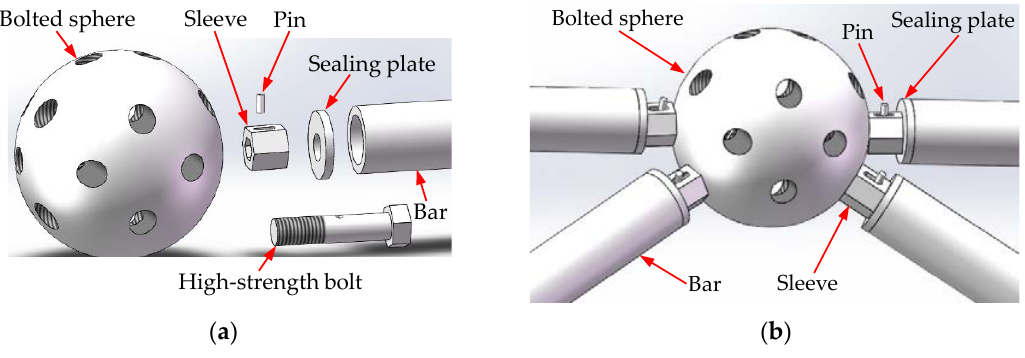
Figure 1. Diagram of bolt-sphere joint structure: ( a ) Bolt-sphere joint parts; ( b ) Bolt-sphere joint.